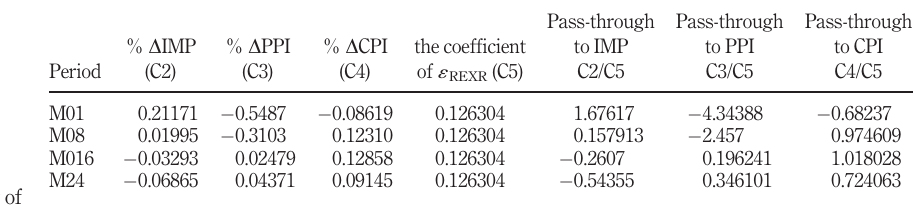
through elasticity